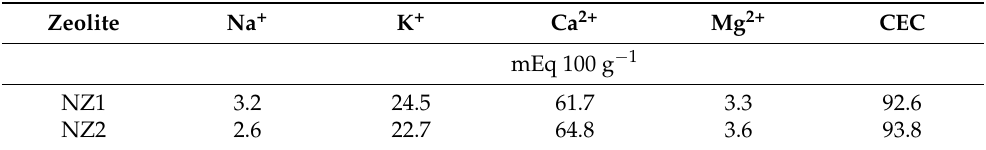
Table 2. Concentrations of exchangeable cations (CEC) of the NZ1 and NZ2 thermally treated samples ( n = 3 parallel